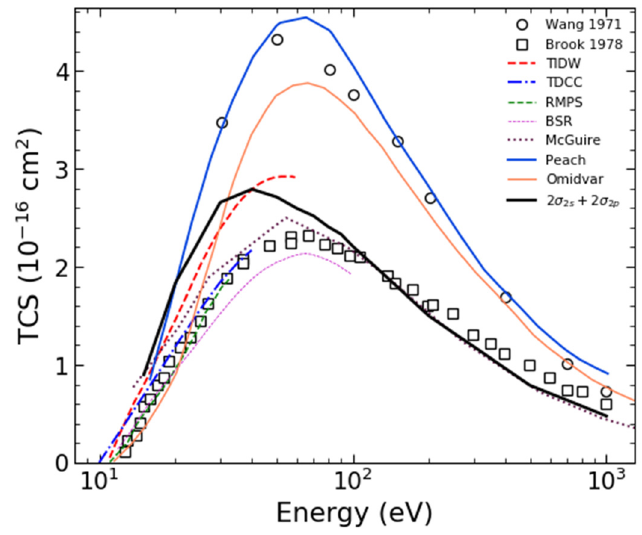
Figure 2. Total ionization cross-section as a function of the impact energy for collisions of electrons with carbon atoms. Expt: dots- Wang and Crawford (Ref. [2]), squares: Brook (Ref. [3]). Theories: dashed-red-line: TIDW, dotted-dashed-blue-line: TDCC, short-dashed-green-line: RMPS, all from Ref. [8]; short-dotted-pink line: BSR [9], solid-blue-line: Peach [4,5], solid-orange-line: Omidvar [6], dotted-magenta-line: McGuire [7], solid-black-line present CTMC results using the standard addition rule.